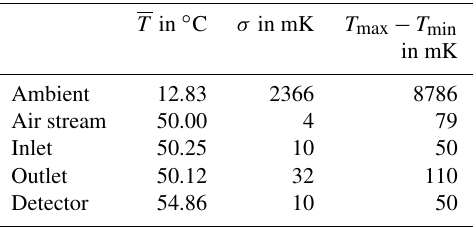
Table 2. Mean T , standard deviation σ and range T max − T min of temperatures under simulated flight conditions.